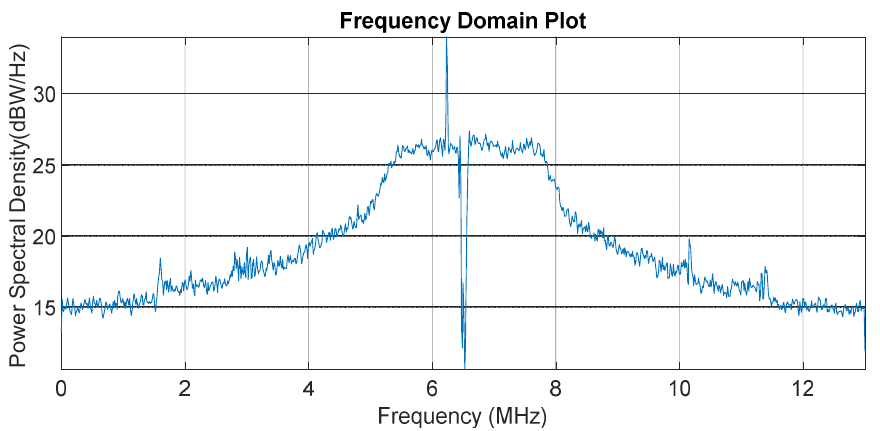
Figure 24. Frequency spectrum of VHDL implementation (fixed-point with 22-precision).